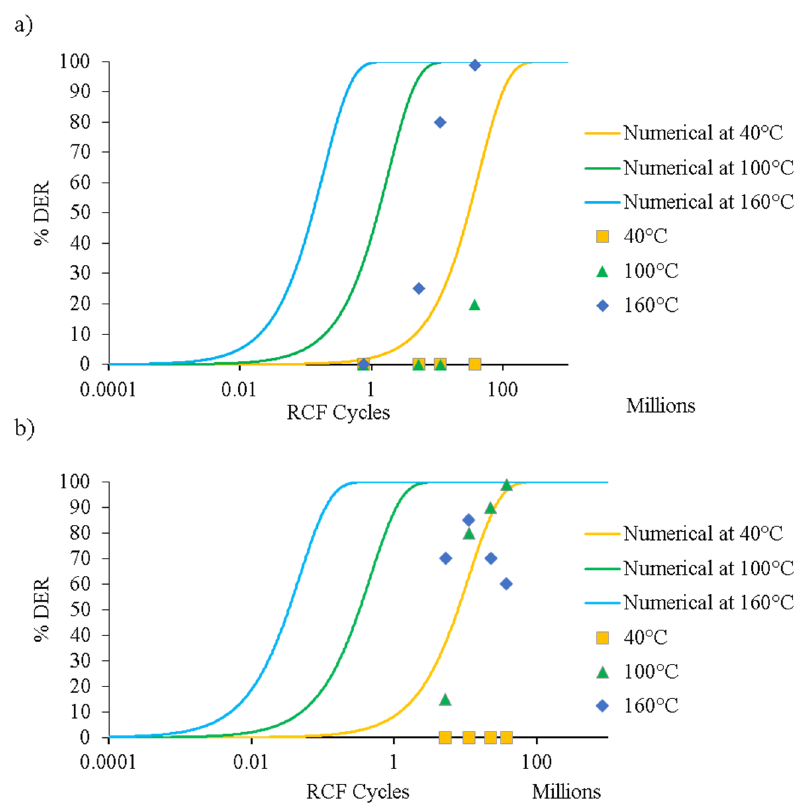
Figure 13. Experimental and numerical prediction of DERs formation at ( a ) 4 GPa and ( b ) 5 GPa contact stress. Adapted from [29].